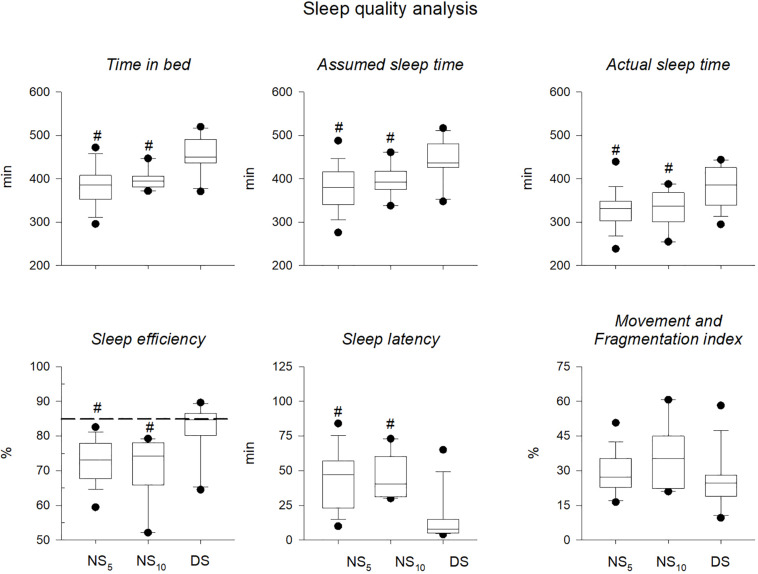
Sleep quality parameters. Time in bed, Assumed sleep time, Actual sleep time, Sleep efficiency, Sleep latency, and Movement and fragmentation index measured during the three shift cycles in the 5-day night shift (NS5), the 10-day night shift (NS10), and the day/swing shift (DS) group. #p < 0.05 NS5 or NS10 vs. DS. Black dots represent the 95th/5th percentile. The dashed line in the Sleep efficiency panel represents 85%, which is defined a cut-off for an adequate sleep efficiency. An average of the entire monitoring period was calculated for each parameter and for each participant.